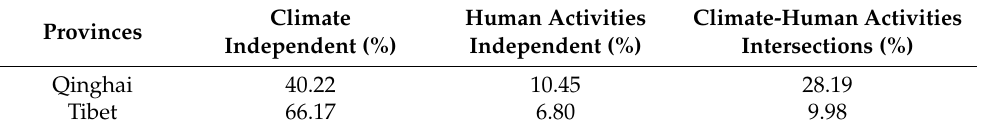
Table 3. Independent contributions of the turning points of climate, human activities, and their intersections to the annual turning points variations of EOS at the province